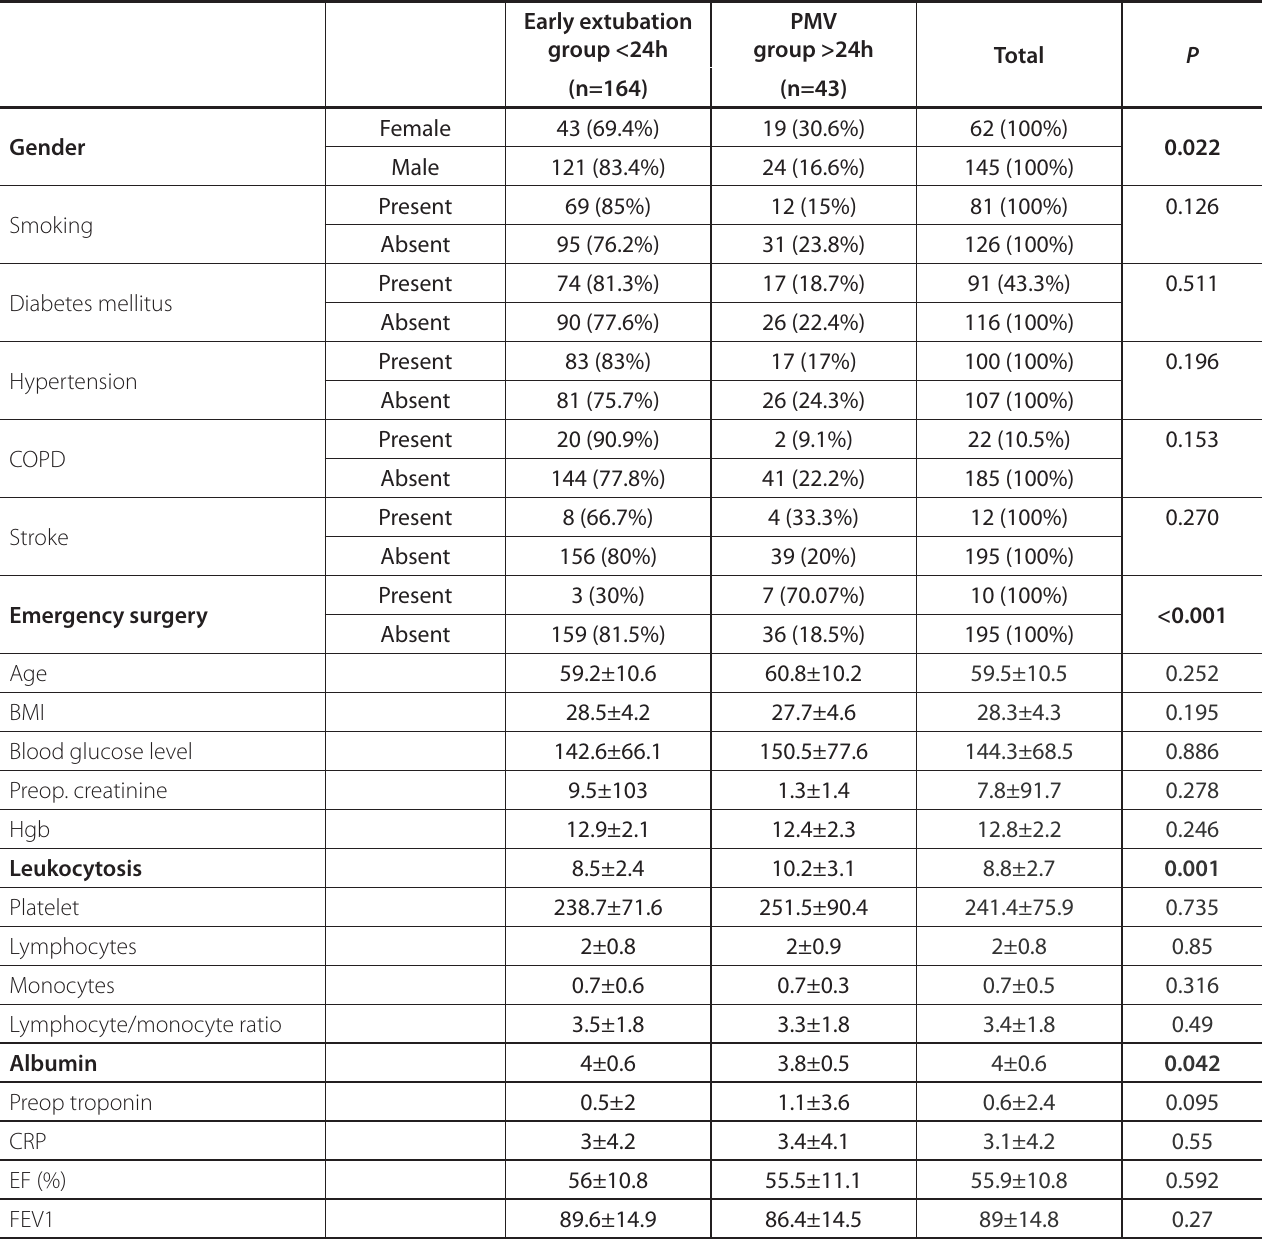
Table 1. Preoperative factors in PMV and early extubation